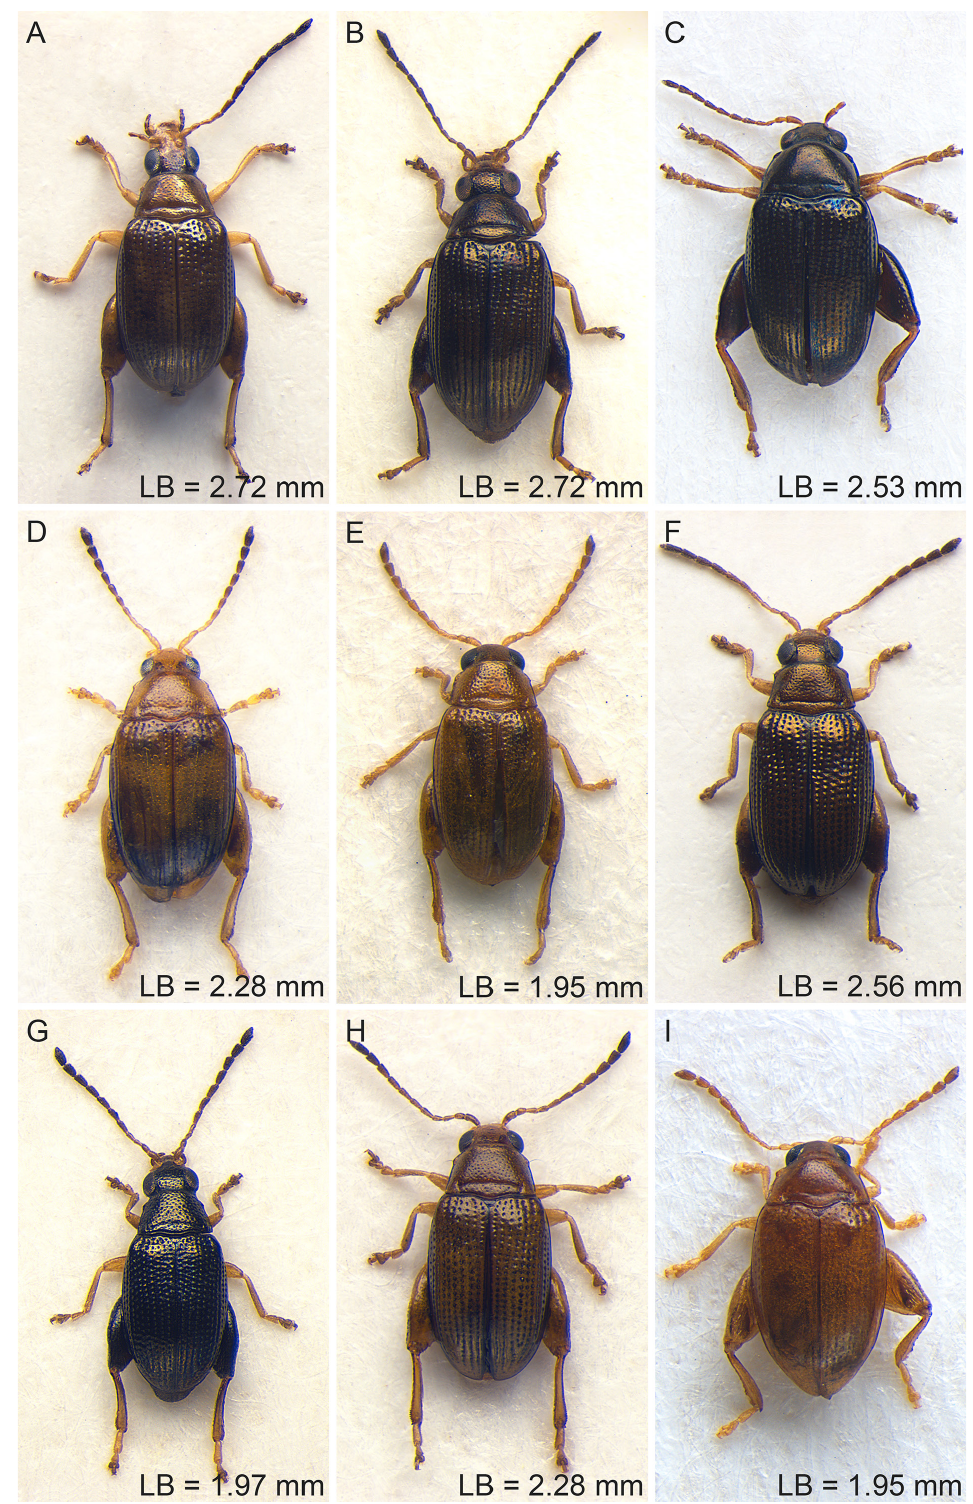
Fig. 2. Habitus. A . Arsipoda longifrons sp. nov, Humboldt S track. B . A. montana sp. nov, Mt